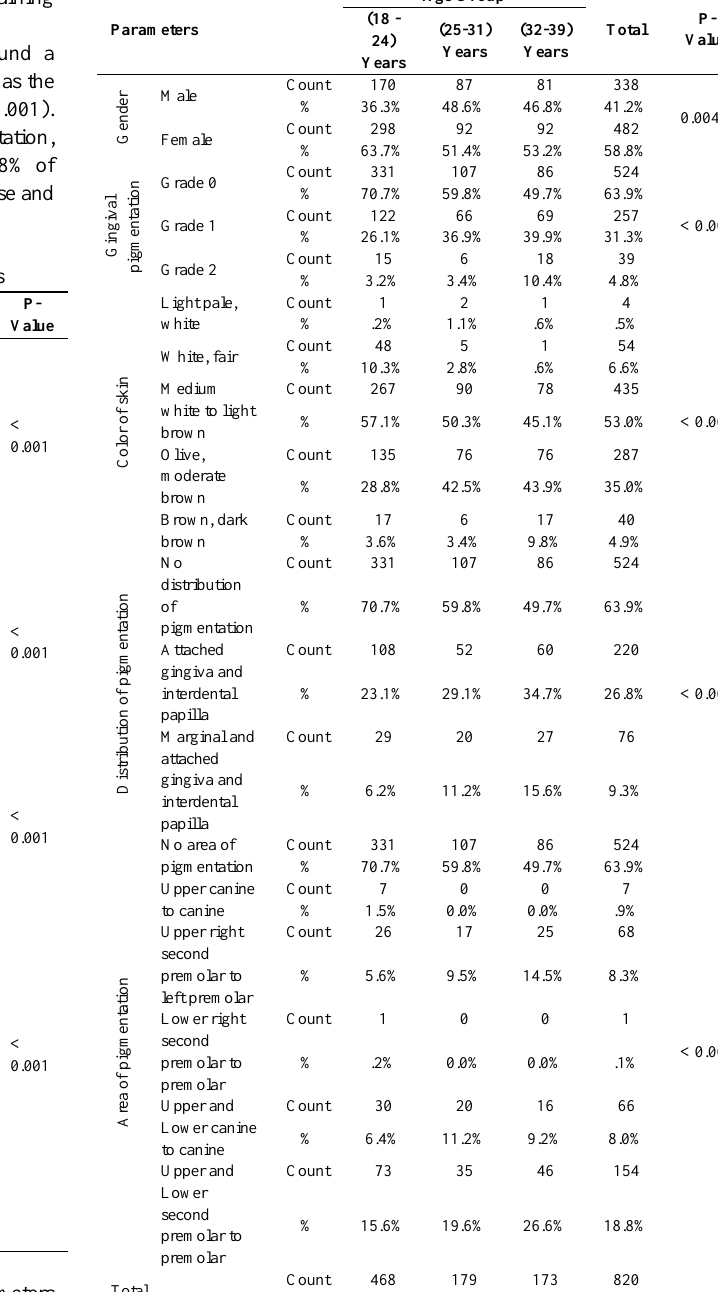
Table 4: Association between age group and other